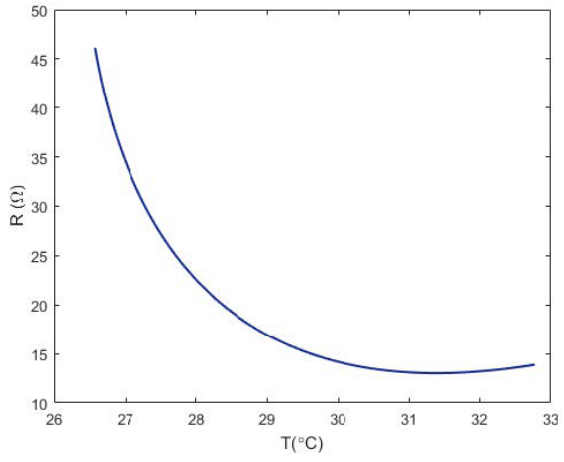
Figure A3. Extracted resistance deviation with respect to the generated temperature in the CNP-based MSM with steel electrodes.